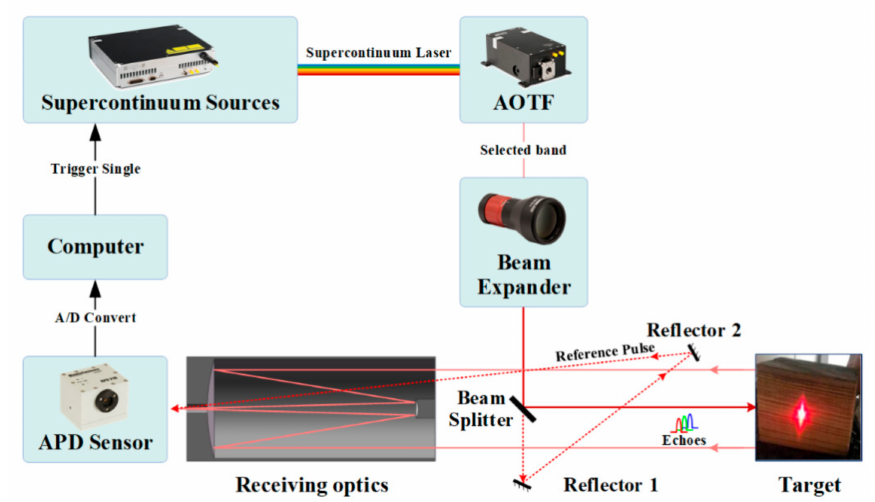
Figure 3. The schematic acousto-optic tunable filter–hyperspectral LiDAR (AOTF-HSL) setup